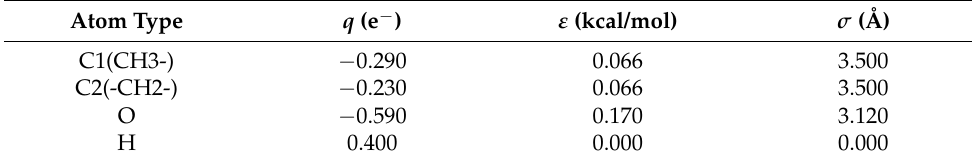
Table 1. Nonbond parameters for alcohols.